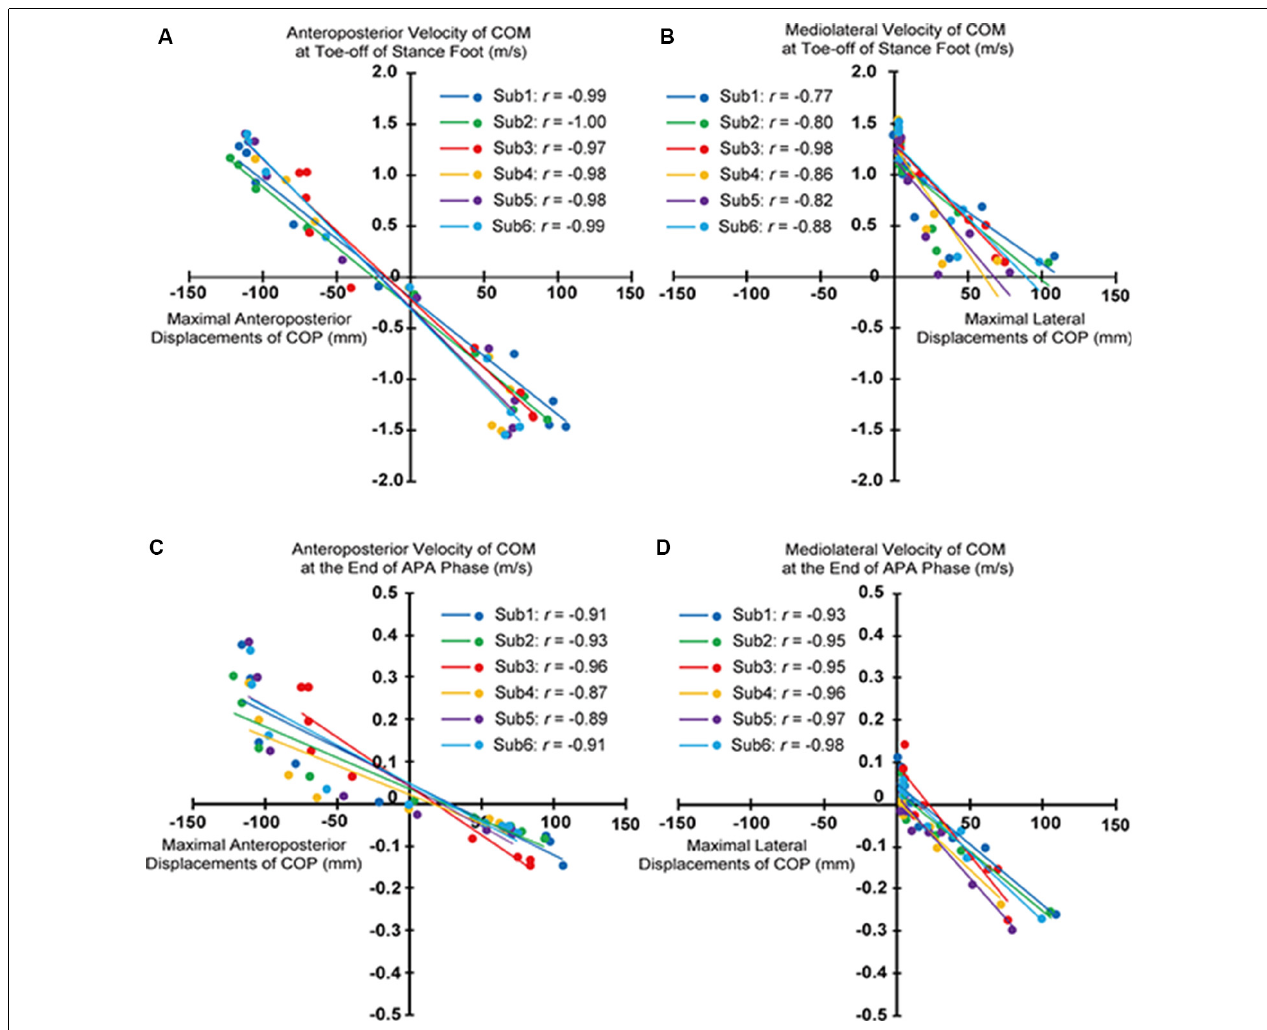
FIGURE 4 | Relationship of the maximal anteroposterior and lateral center of pressure under feet (COP) displacements and anteroposterior and mediolateral components of velocity of the center of mass of whole-body (COM) at toe-off of stance foot (A,B) and at heel-off of stepping foot (C,D) for each